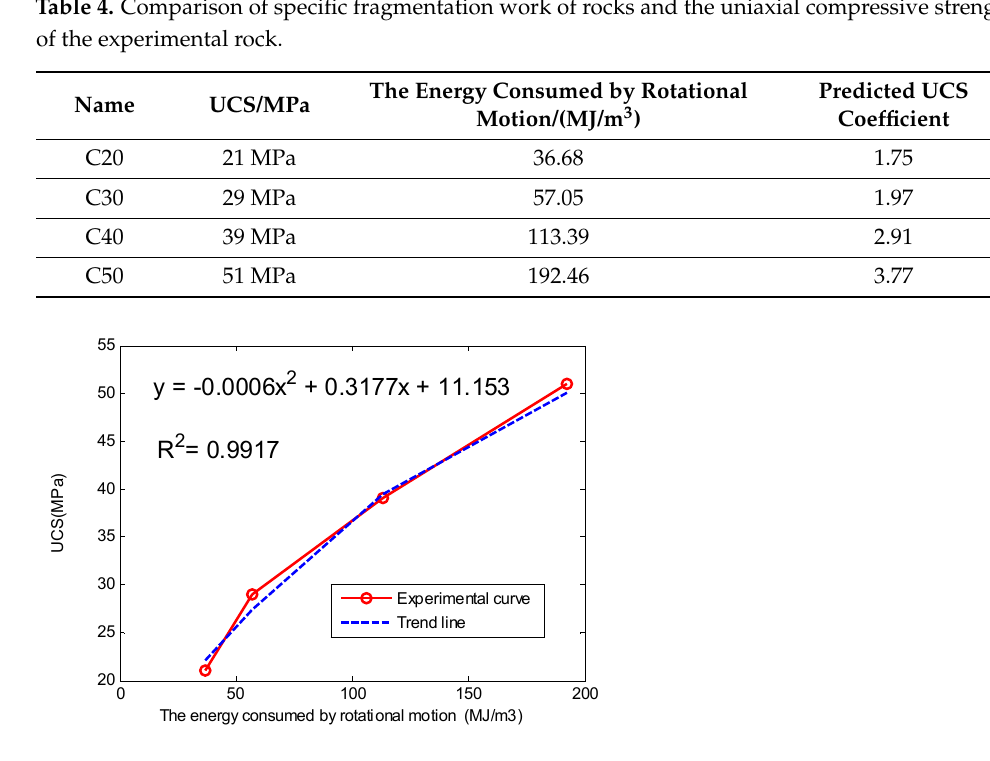
Table 3. Bit input and output average parameters.